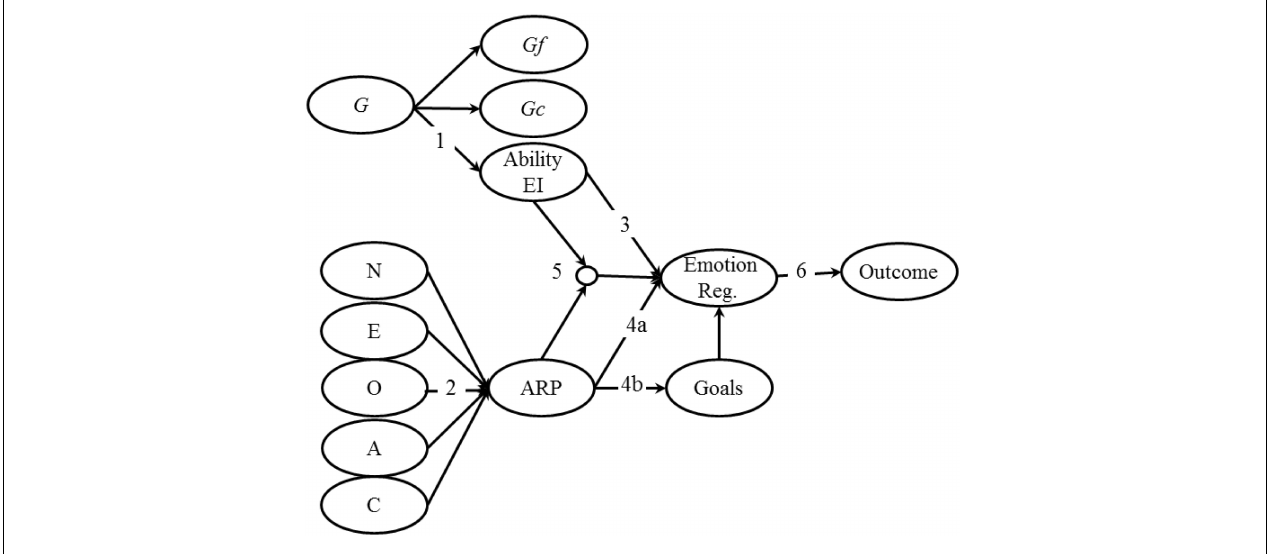
FIGURE 2 | Integrated model of affect-related individual differences. G, general factor of intelligence; Gf, fluid intelligence; Gc, crystallized intelligence; N, neuroticism; E, extraversion; O, openness; A, agreeableness; C, conscientiousness; ARP, affect-related personality traits; Emotion reg., emotion